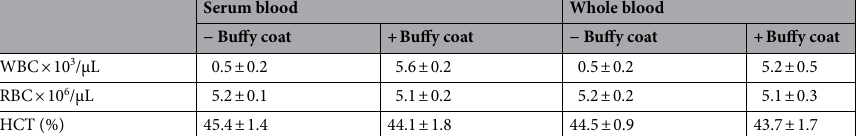
Serum blood Whole blood − Buffy coat + Buffy coat − Buffy coat + Buffy